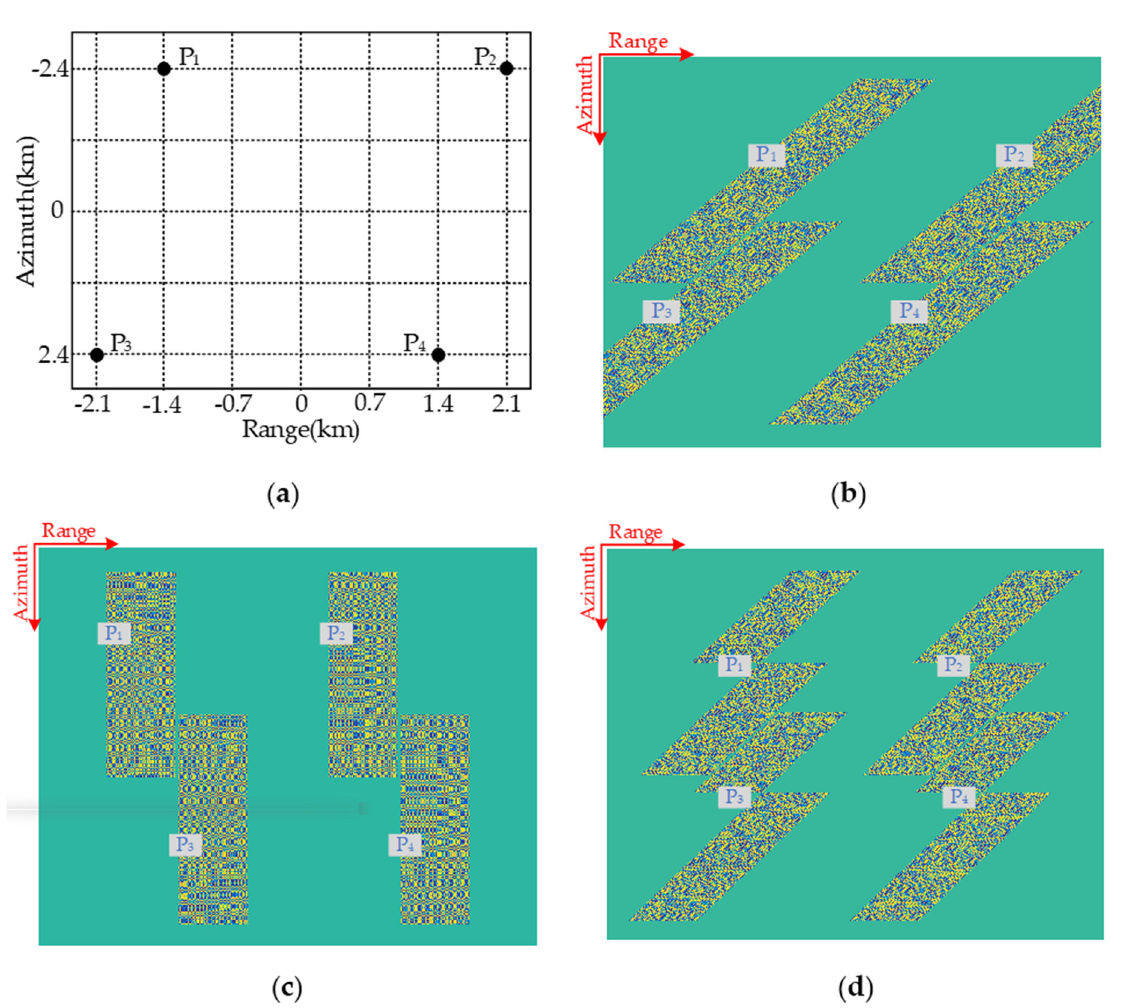
Figure 6. Echo simulation with different pulse transmission sequences. ( a ) Scene distribution of targets; ( b ) the fixed PRF; ( c ) the CV-PRF; ( d ) the